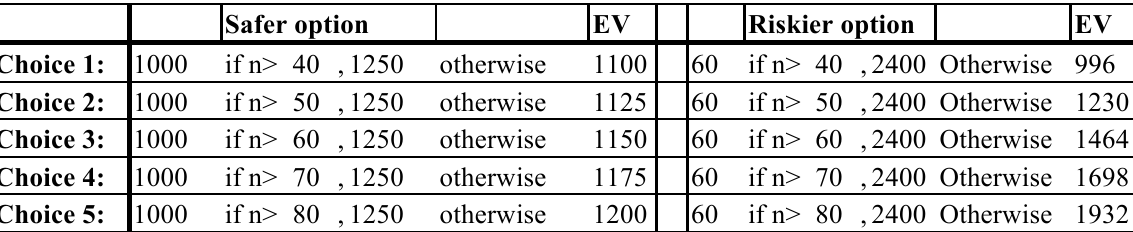
Table 3. Elicitation of risk aversion.